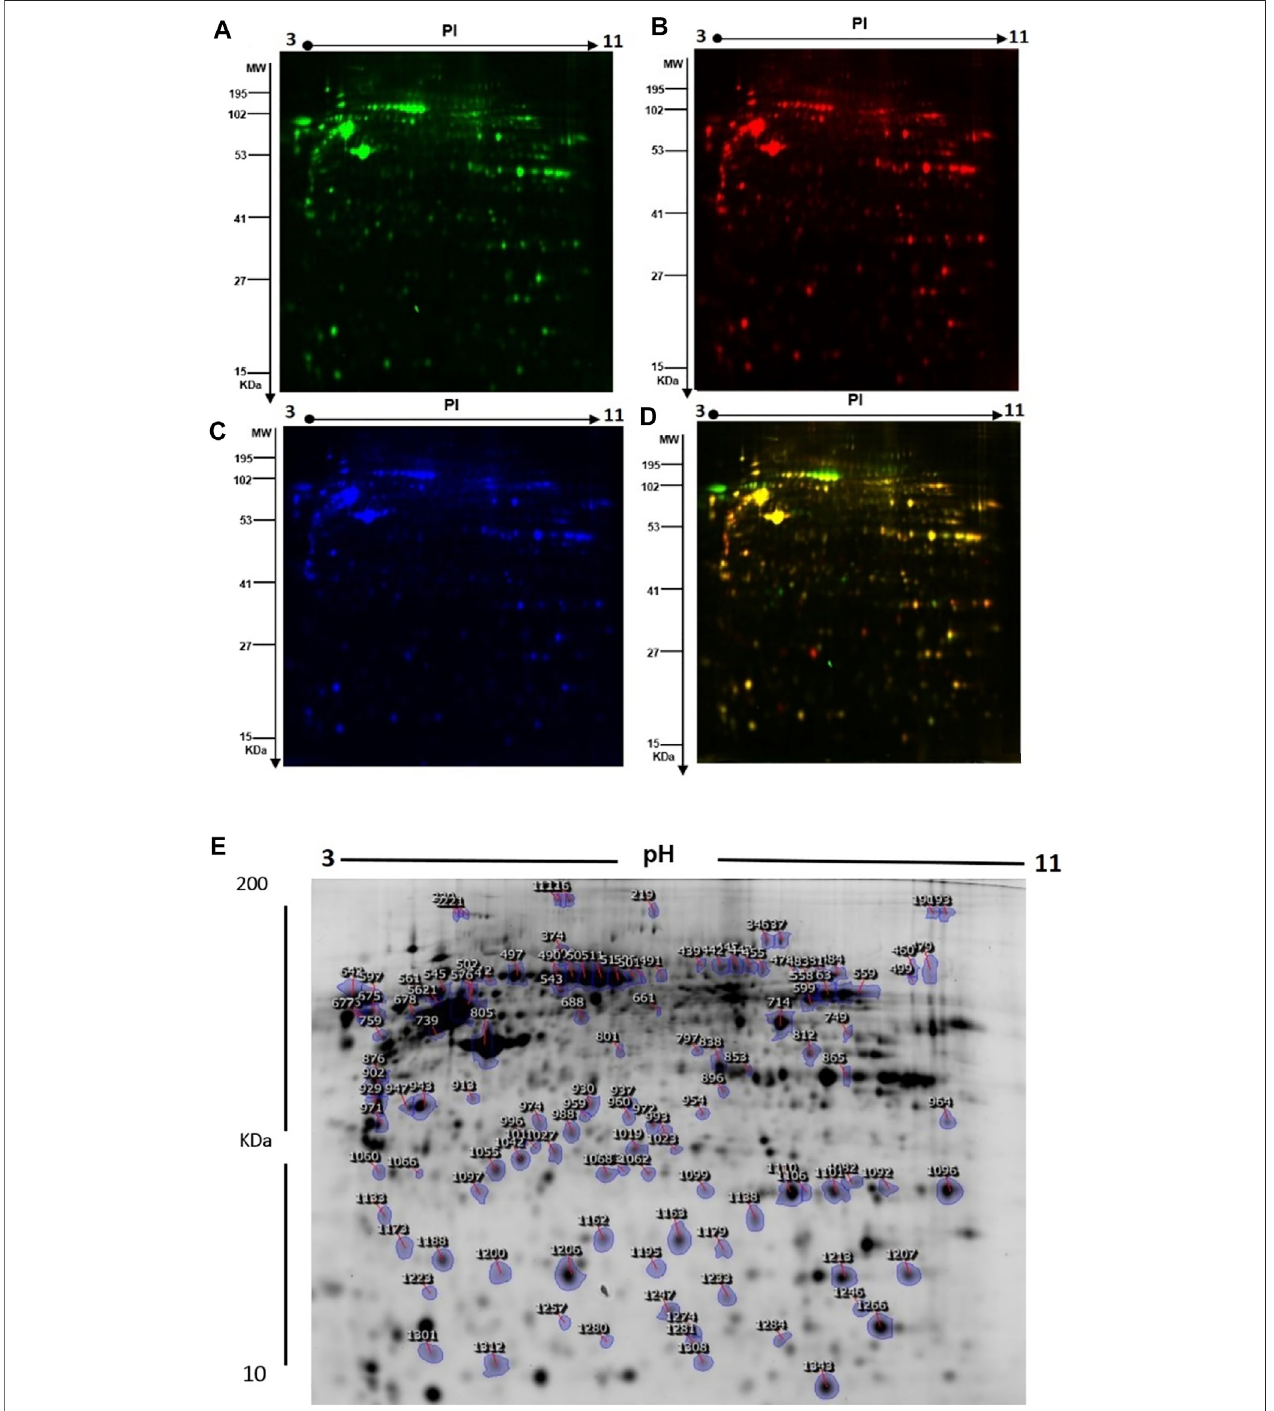
FIGURE 3 | (A) Representative fl uorescent protein pro fi les of the 2D-DIGE containing Cy3-labeled control samples. (B) Cy5-labeled samples from patients with GAMOS. (C) Pooled Cy2-labeled internal control. (D) Cy3/Cy5-merged 2D-DIGE comparison. (E) Representative image of protein spots from the skin fi broblasts. Numbered spots indicate those identi fi ed to be differentially expressed (over 1.5-fold change, p < 0.05) and successfully identi fi ed with MALDI-TOF/TOF.